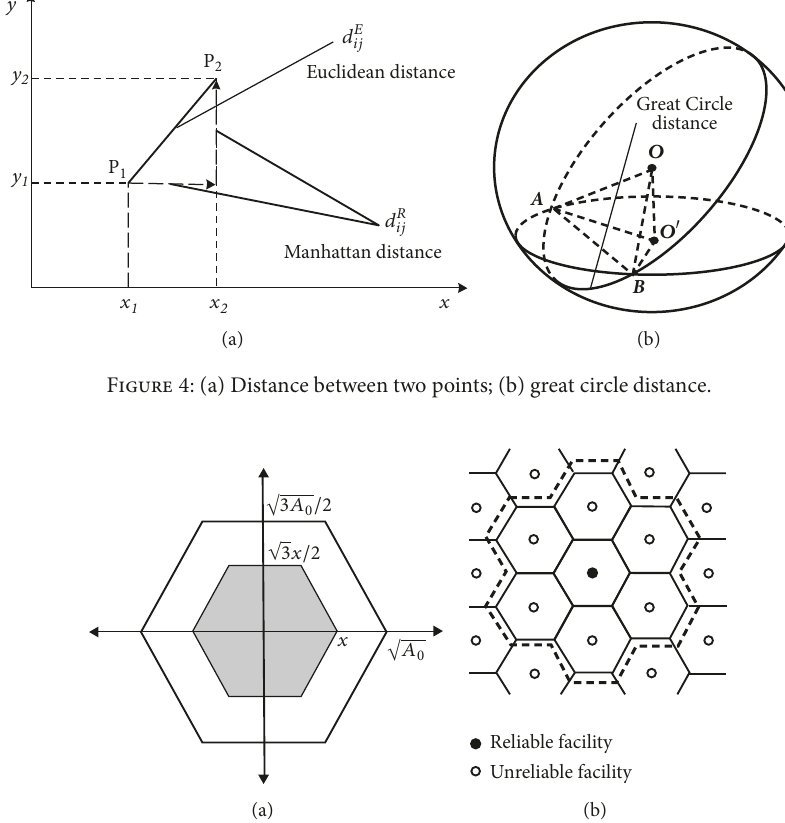
Figure 5: (a) A hexagonal subregion 𝐺 0 ; (b) facility location set (topo-area, 𝑛 0 = 7